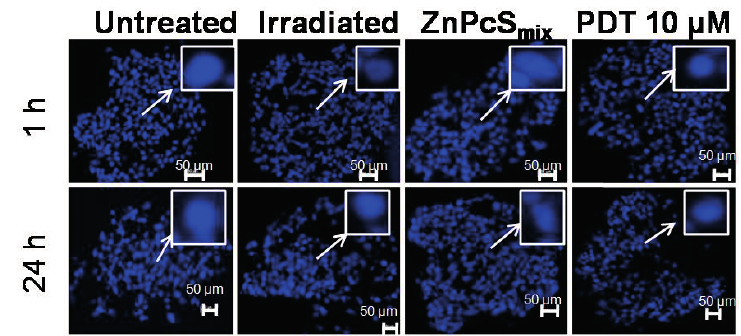
Figure 5. Fluorescence micrograph of multicellular tumour spheroids (MCTSs) with a size of 500 µm stained with Hoechst 33342, 1 or 24 h post incubation. Scale bar denotes 50 µm in MCTSs. The arrows show enlarged